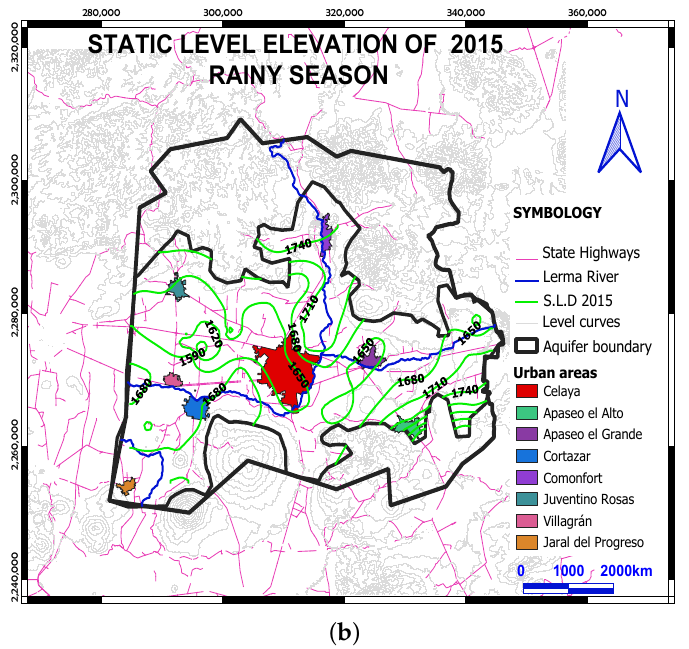
Figura 1.18: Temporada de Lluvias: Elevaci´on del nivel est´atico en el a˜no 2015. Figure 7. Rainy season of 2015. ( a ) Distribution of static level depth lines. ( b ) Distribution of static level elevation